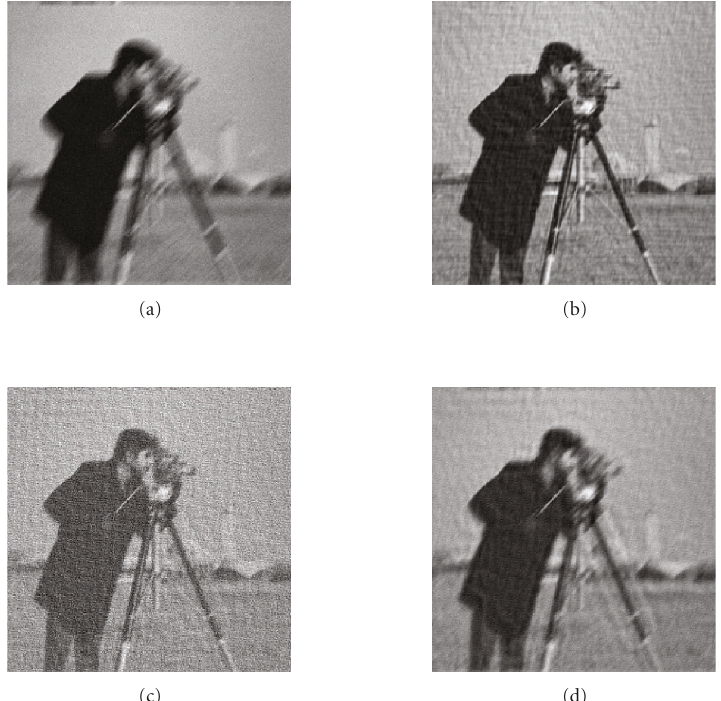
Figure 7: From Figure 6, we take a specific pair of values (BSNR, ε σ ) = (20dB,80%) showing the degraded image y in (a) and the restored images (cid:2) x in (b), (c), and (d) when, respectively, obtained by the Wiener filter with optimum estimates (ISNR = 4 . 14dB), the same when an error of ε σ is applied on the noise variance (ISNR = − 3 . 25dB) and the last one when our proposed desensitisation method is used with the same error (ISNR = 1 .